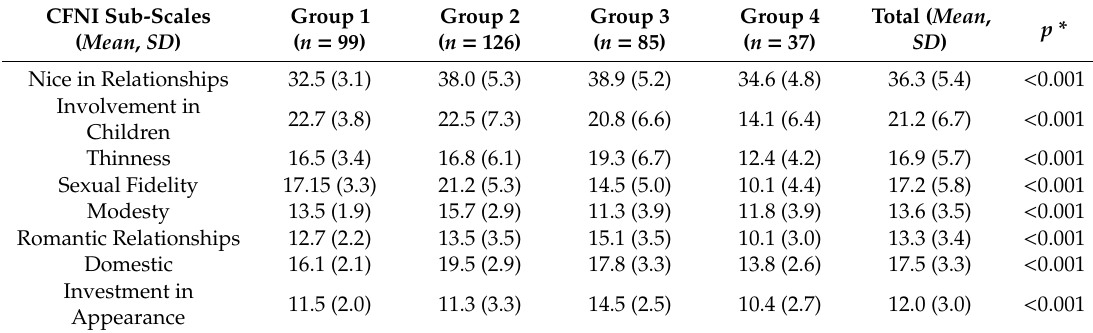
Table 3. Characteristics of the formed groups by CFNI subscales.